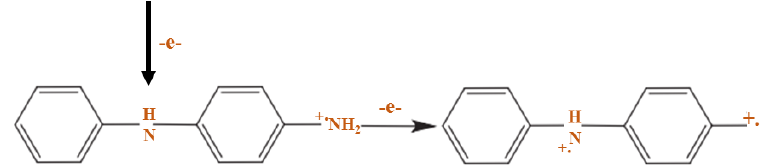
Figure 9. Structure for the radical cation of dimer. Reproduced with permission from Materials